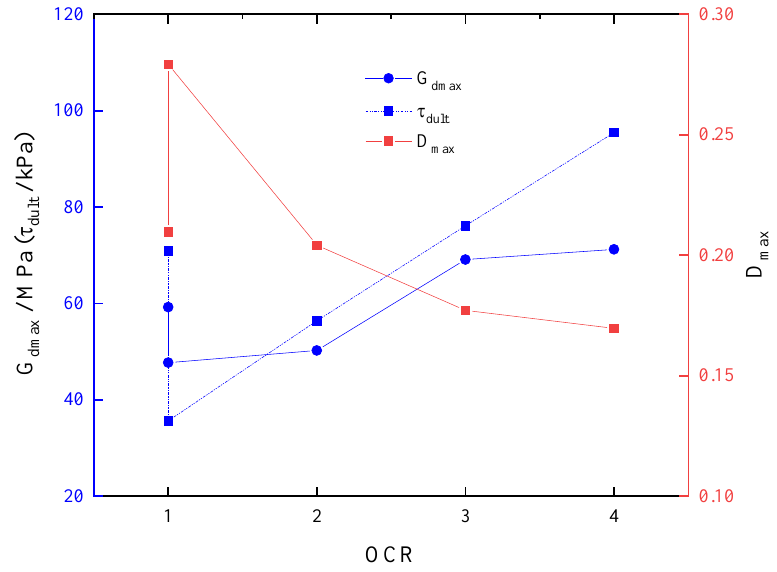
Figure 14. Influence of OCR on G d max , τ dult, and D max.